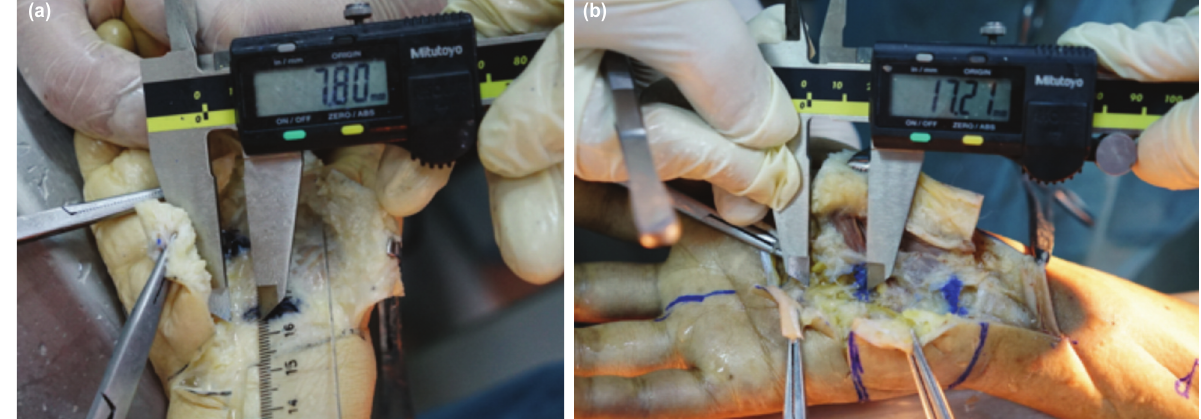
(a) Measuring distance between the vertical line and the ulnar neurovascular bundle. (b) Measuring distance between the distal Fig. 3: margin of the transverse carpal ligament and the superficial palmar arch.